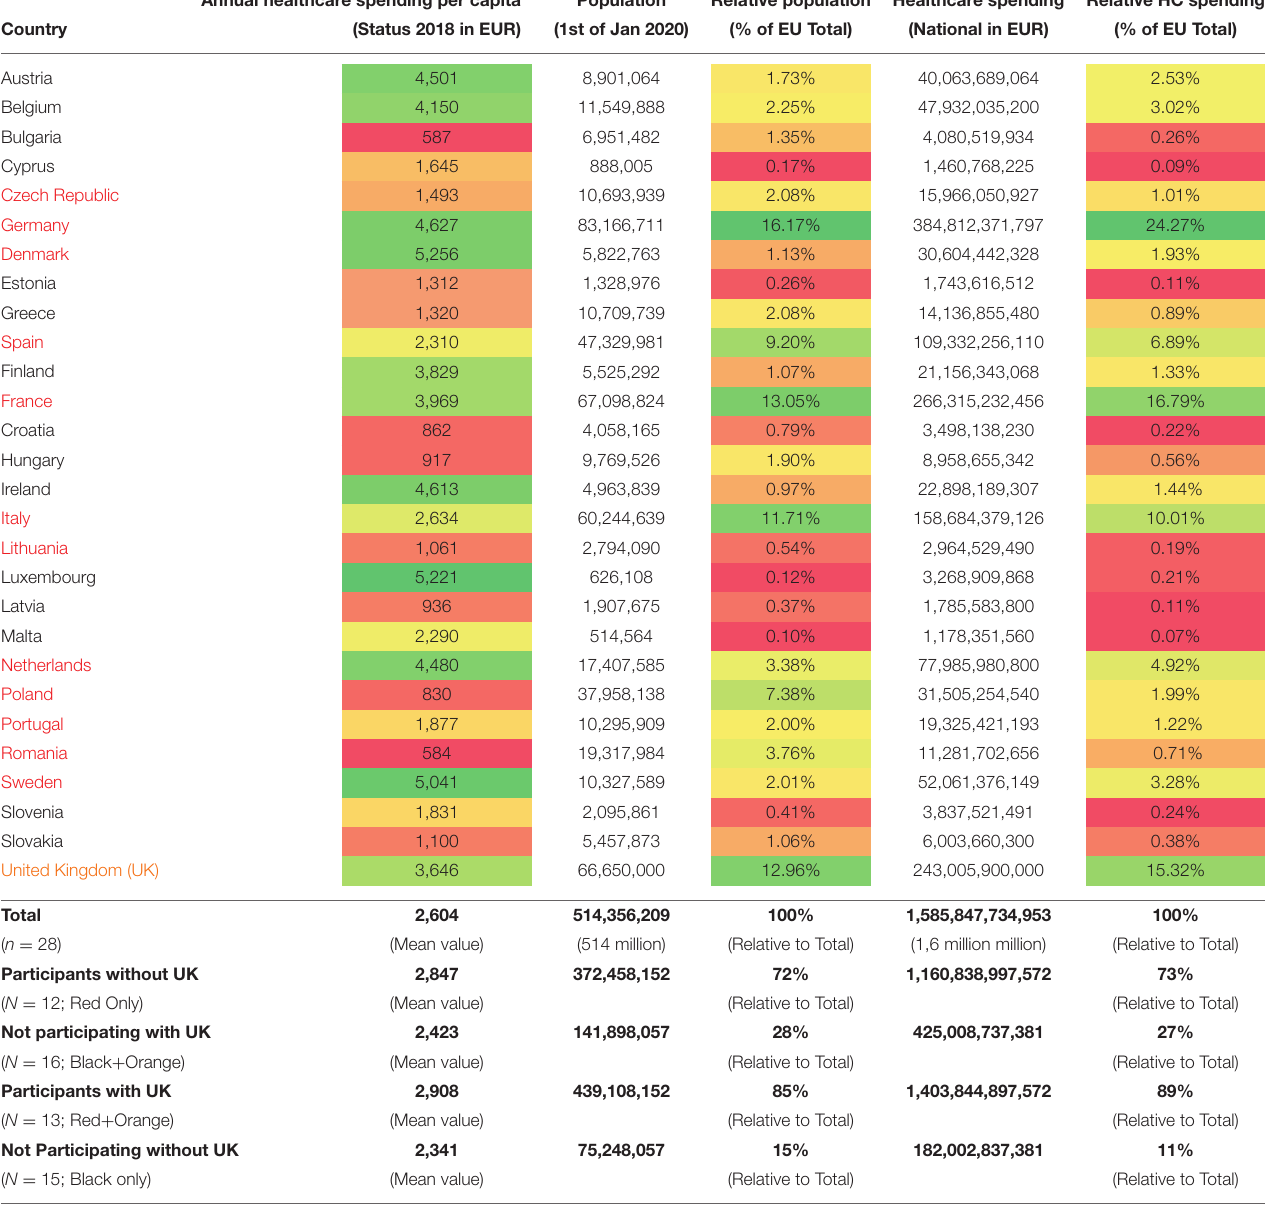
TABLE 2 | European populations, and per capita, relative and total healthcare spending (the surveyed European countries are marked in red/orange; currency Euro, EUR). Annual healthcare spending per capita Population Relative population Healthcare spending Relative HC